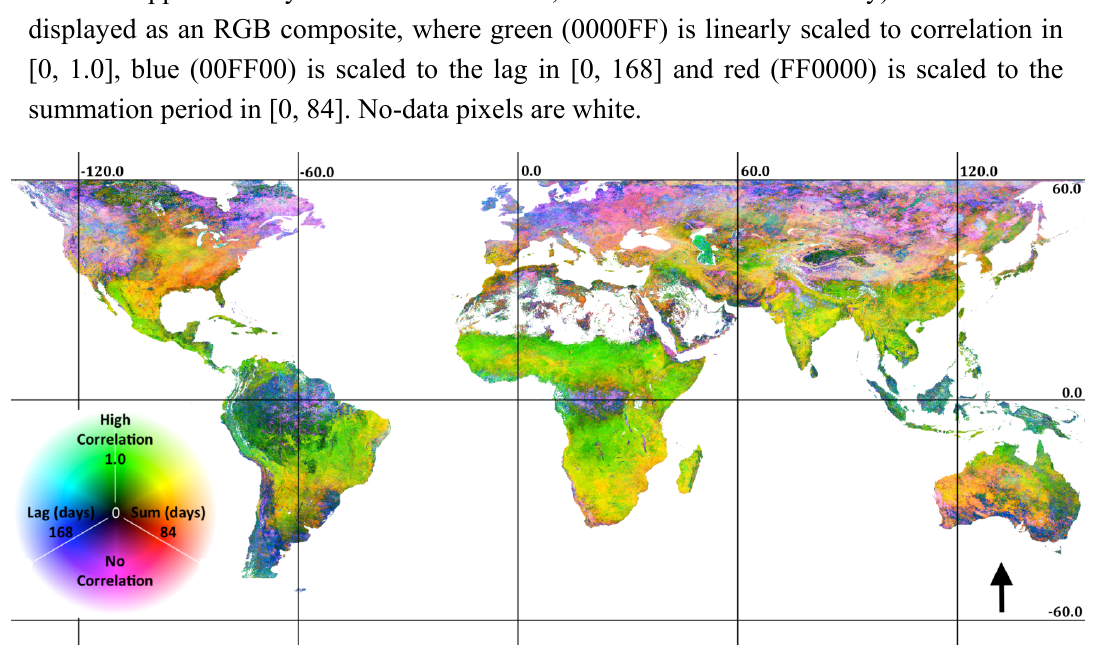
Figure 2. p -values associated with the precipitation correlations shown in Figure 1. 1-km